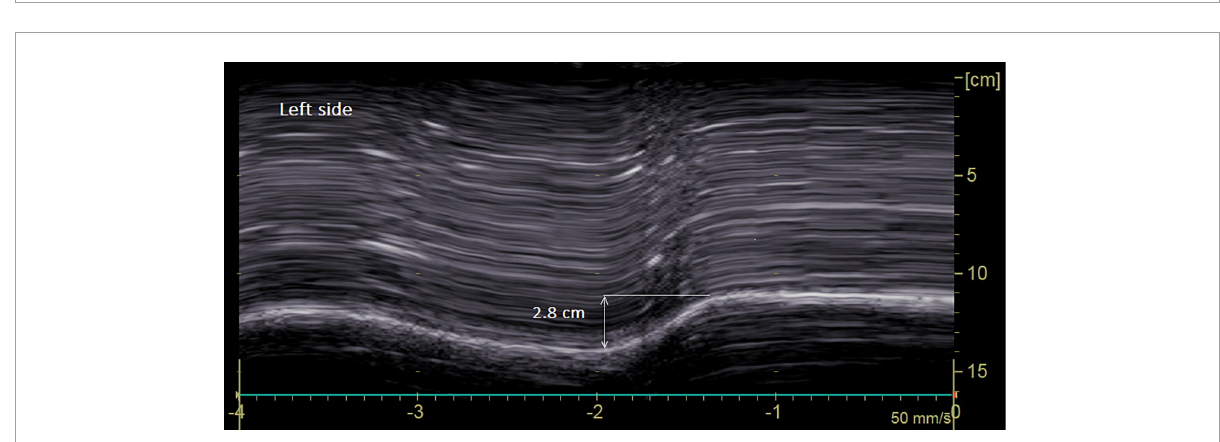
FIGURE3 Diaphragmatic motion recorded by M-mode ultrasonography in a man suffering from left hemidiaphragm dysfunction. On the left side : marked decrease in hemidiaphragm excursion during deep breathing (2.8 cm for a lower limit of normal = 4.2